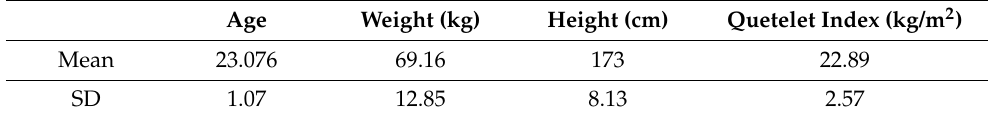
Table 1. Demographic characteristics of subjects.